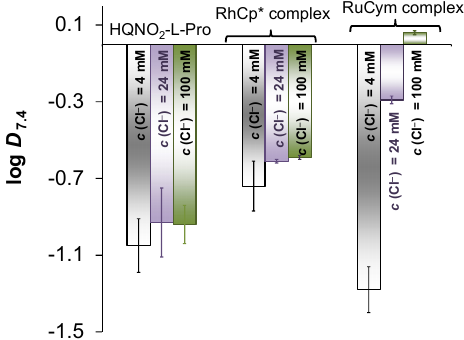
Figure 2. n -Octanol/water distribution coefficients at pH = 7.4 (log D 7.4 ) determined for HQNO 2 -L-Pro and its RhCp* and RuCym complexes at different chloride ion concentrations: 4 mM, 24 mM and 100 mM (indicated on the columns), which correspond to the chloride content of the blood serum, cytosol, and nucleus. {pH = 7.40 (20 mM phosphate buffer); t = 25.0 °C}.